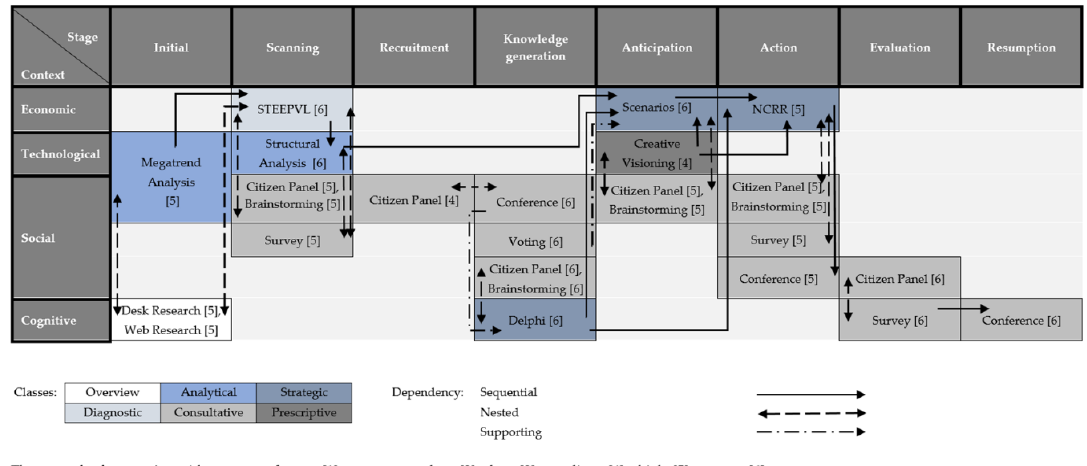
Figure 2. Methodology of planning and implementation of the vision of smart city development.